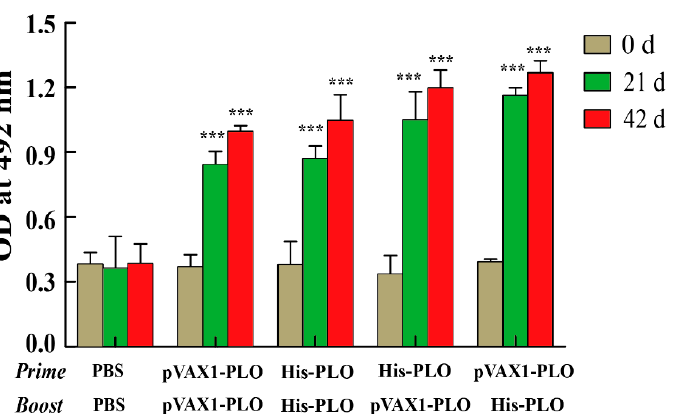
Figure 3. Proliferation of lymphocytes in the spleens of immunized mice. Spleens were collected from the immunized mice at indicated time point. PBS was used as a control. The lymphocytes from the spleen of mice were separated and their proliferation was determined by MTT assay. The purified recombinant His-PLO protein was used as stimuli. Absorbance was detected at 490 nm. Data represented means ± SEM of three independent experiments. *** p < 0.001.